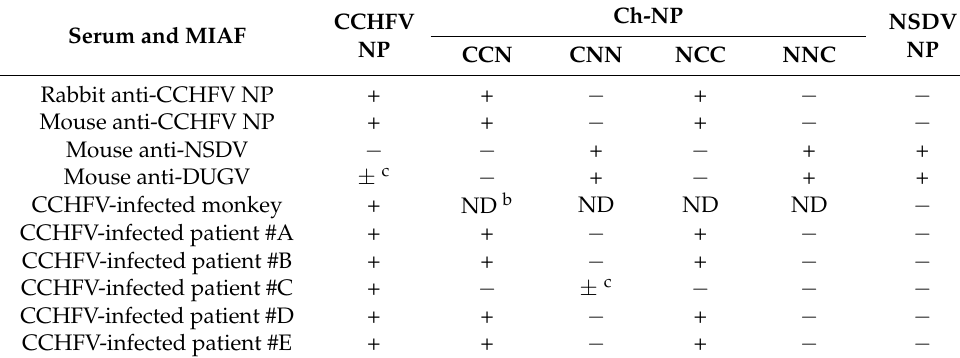
Table 1. Reactivities of anti-CCHFV serum and MIAF to NPs in Western blotting a